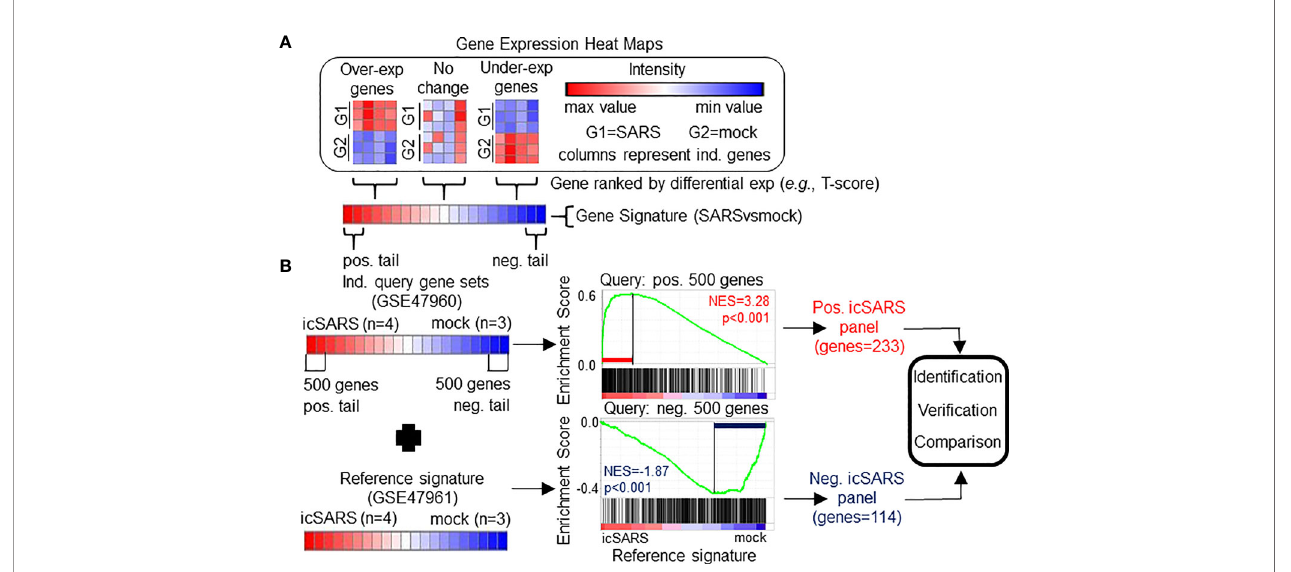
FIGURE 1 | Gene Signature De fi nition and Generation icSARS Gene Panels. (A) Schematic de fi nition of a gene signature. Differences in gene expression between two groups, such as SARS and mock infected lung cells, are measured by Welch ’ s two-sample T − test score. Gene signatures are ranked lists of genes from high (red) to low (blue) differential mRNA expression between groups. (B) Generation of icSARS gene panels for use in this study. To identify differentially expressed genes associated with icSARS infection in human airway epithelial cell cultures, query gene sets containing either the 500 most over- or under-expressed genes from positive or negative tails of the gene signature generated from the Gene Expression Omnibus (GEO) accession number GSE47960 mRNA expression dataset. The positive and negative tail query sets were compared individually to the gene signature generated from the GEO GSE47961 dataset, which was used as reference for Gene Set Enrichment Analysis (GSEA). From this GSEA computed two enrichment plots, one for each query set, and their associated normalized enrichment score (NES) and p-value which represent the extent of enrichment between query set and reference signature. GSEA also identi fi ed leading-edge genes, which are genes that contribute most to achieving maximum enrichment. Two gene panels were de fi ned from leading-edge genes identi fi ed in each query set. These gene panels were used in this study for three purposes: 1) identi fi cation of gene expression changes associated with icSARS infection in human airway epithelial cell cultures, 2) veri fi cation of identi fi ed fi ndings in independent datasets, and 3) comparison to other gene signatures representing changes in gene expression associated with other SARS